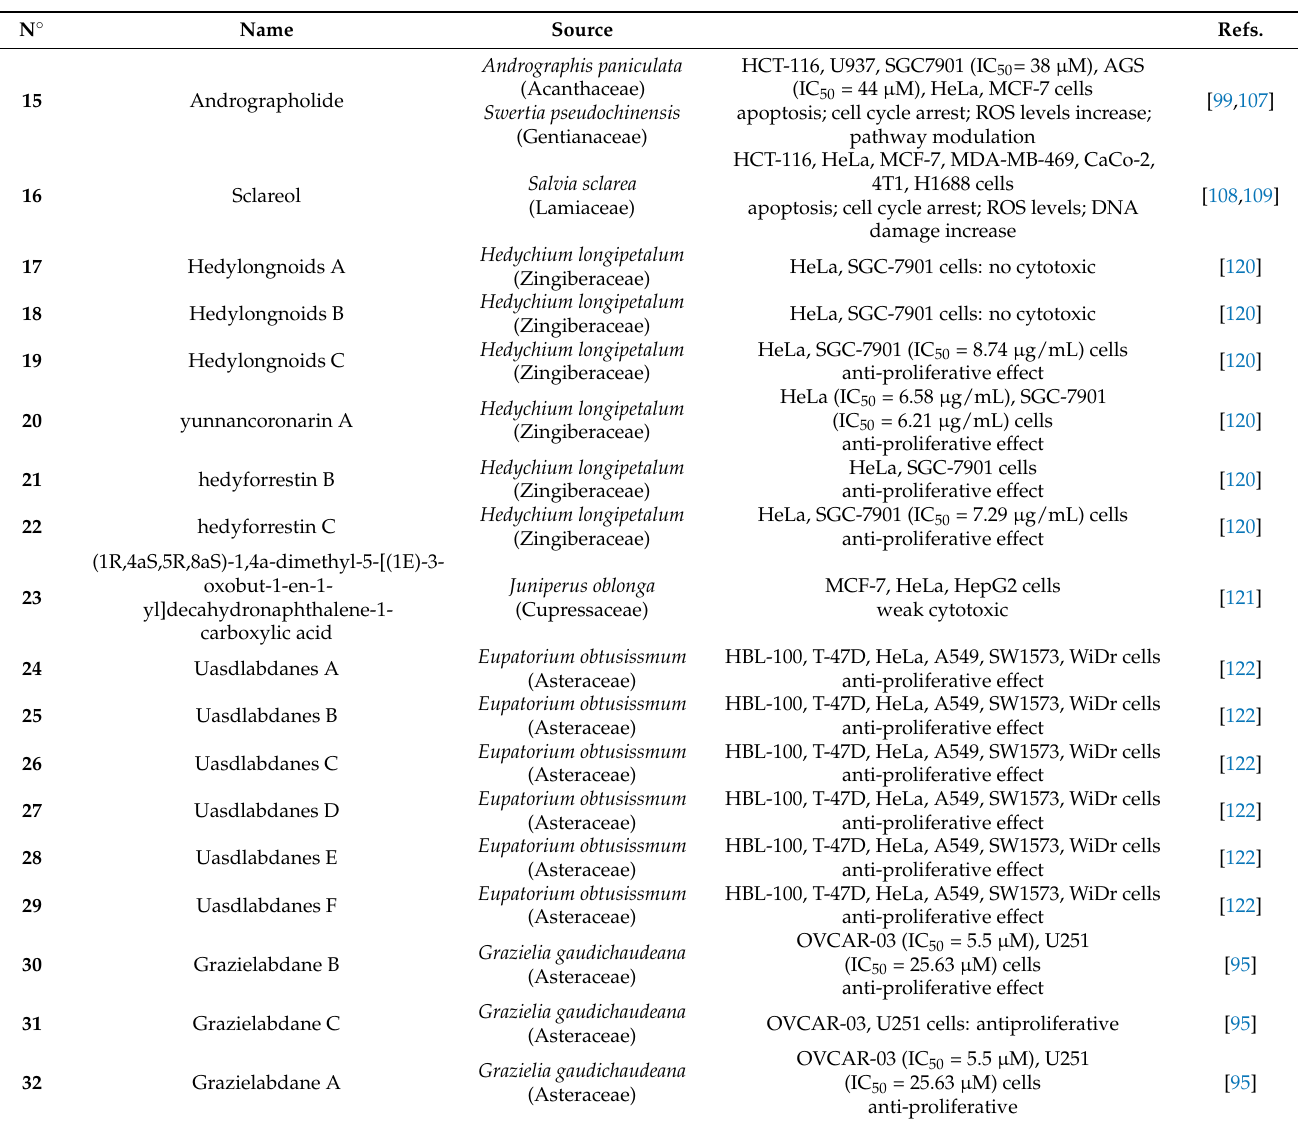
Table 2. Sources and biological activities on cancer cell lines of labdane